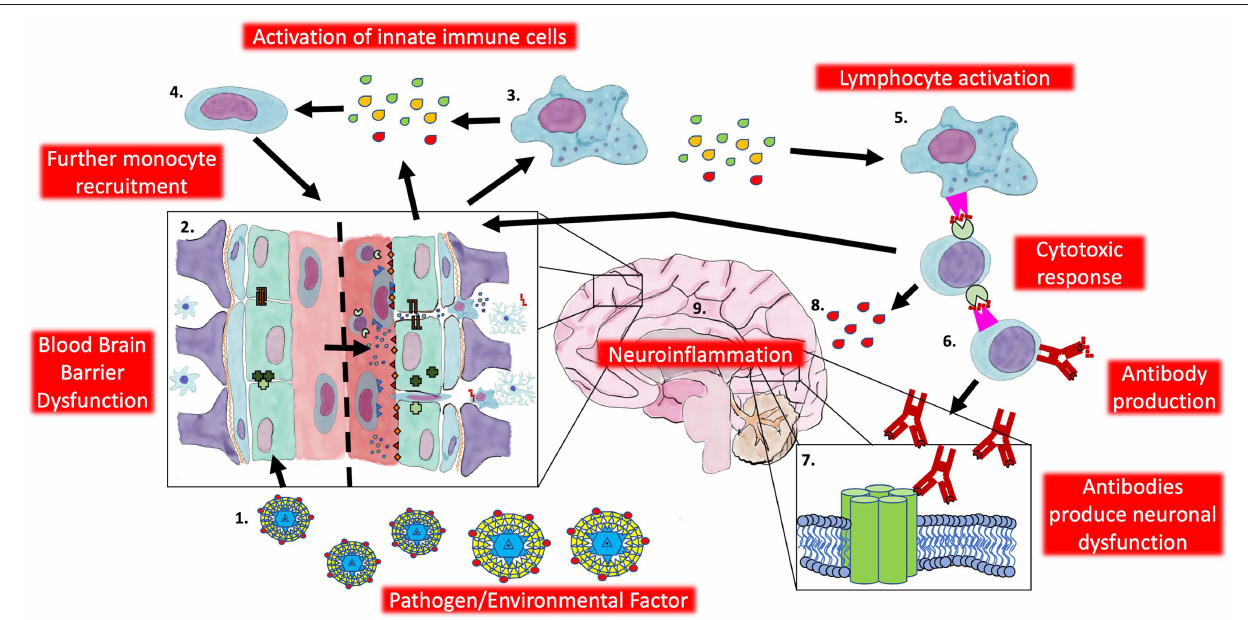
FIGURE 2 | Potential innate contribution to the pathogenesis of autoimmune encephalitis. 1. An exogenous factor (i.e., herpesvirus) infiltrates the CNS resulting in 2. blood brain barrier dysfunction and infiltration of innate and adaptive cells. 3. Activated innate cells (i.e., Macrophages and microglia) release pro-inflammatory cytokines (IL-1 β , TNF- α , Interferon- γ ) and chemokines (CCL2) to 4. recruit more innate cells and contribute further to BBB dysfunction. Pro-inflammatory cytokines and chemokines also recruit lymphocytes and innate cells act as 5. antigen presenting cells to activate T cells and initiate a specific response against neuronal antigens. 6. T cells interact and activate B cells to produce an antibody response 7. directed against neuronal targets resulting in neuronal dysfunction while 8. directing a cytotoxic response against neuronal tissue (and contributing to the pro-inflammatory cascade) resulting in 9. neuroinflammation. CNS, Central nervous system; IL-1 β , Interleukin-1 β ; TNF- α , Tumor necrosis factor- α ; CCL2, C-C motif chemokine ligand 2; BBB: Blood brain barrier.